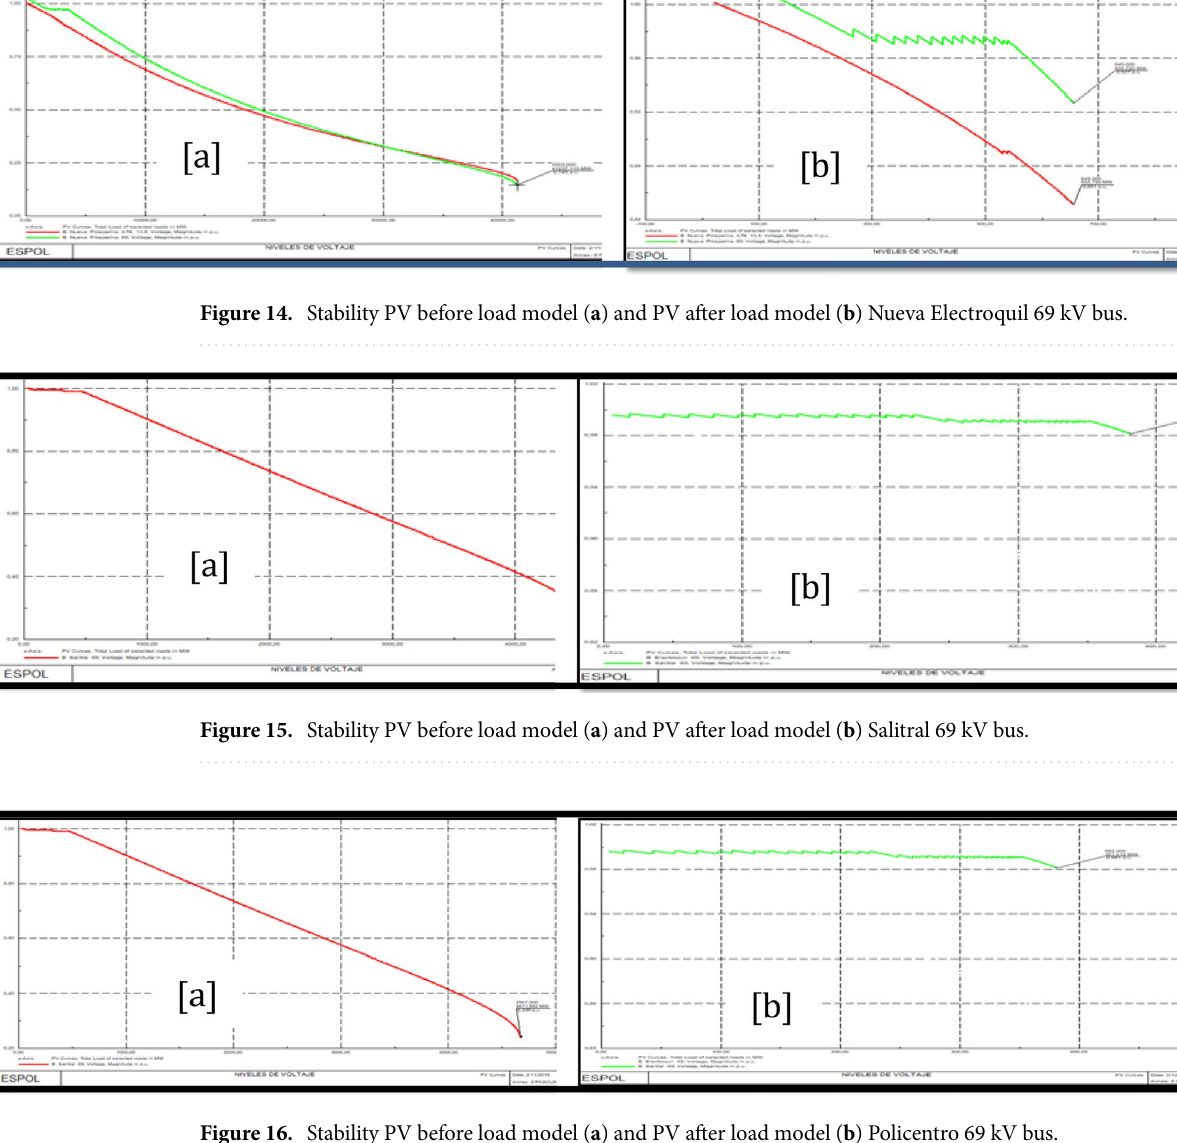
Figure 16. Stability PV before load model ( a ) and PV after load model ( b ) Policentro 69 kV